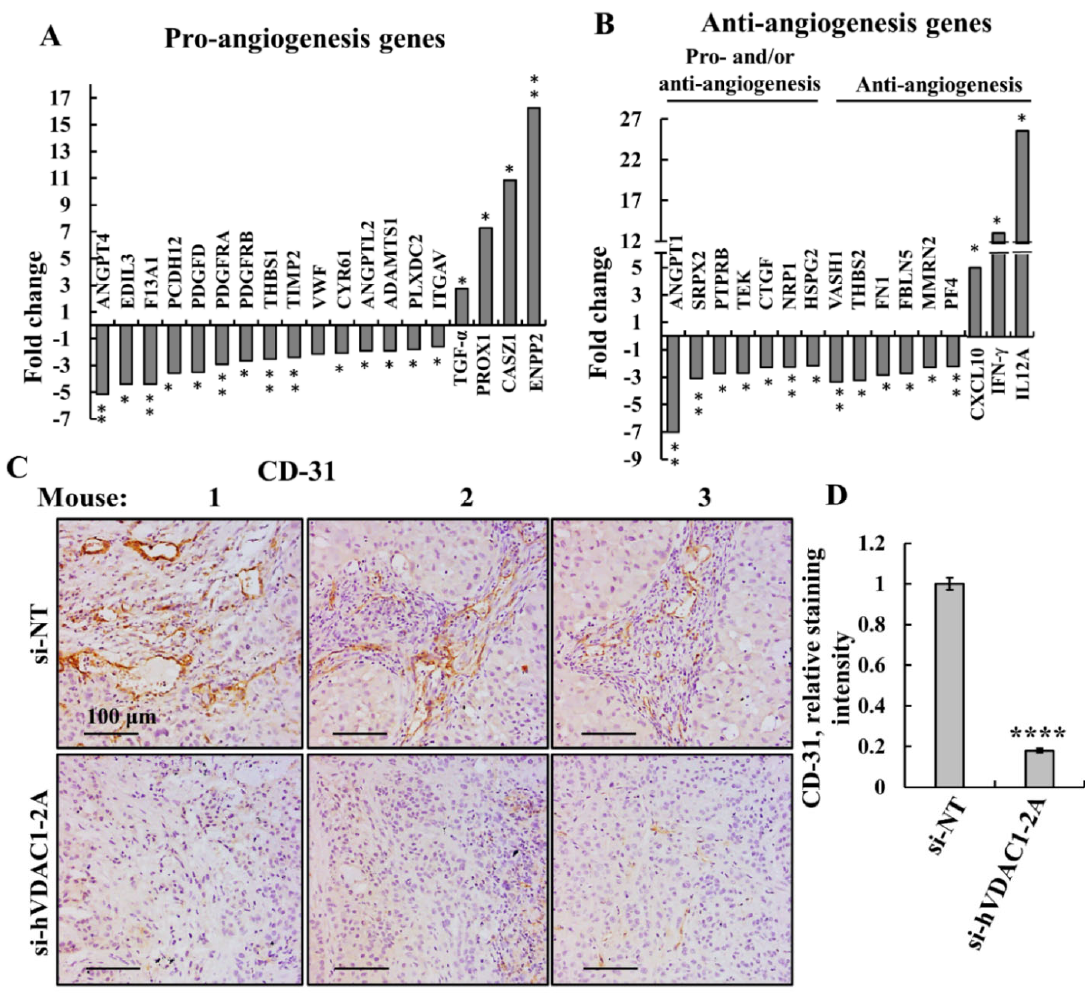
Figure 7. si-hVDAC1-2A tumor treatment alters the expression of angiogenesis-related mouse genes. Differentially expressed angiogenesis-related genes of murine origin found to be enriched using DAVID Gene Ontology analysis are presented as the fold change in si-VDAC1-2A-TTs relative to si-NT-TTs. ( A ) Pro-angiogenesis genes. ( B ) Anti-angiogenesis genes, as well as genes encoding for anti- or pro-angiogenesis factors, depending on the conditions. In all cases, * p ≤ 0.05, ** p ≤ 0.01. Representative IF stained sections from si-NT-TTs and si-hVDAC1-2A-TTs derived from A549 xenografts stained with anti-CD-31 antibodies ( C ). Quantitative analysis of CD-31 staining intensity, presented as means ± SEM, **** p < 0.0001 ( n = 3) ( D